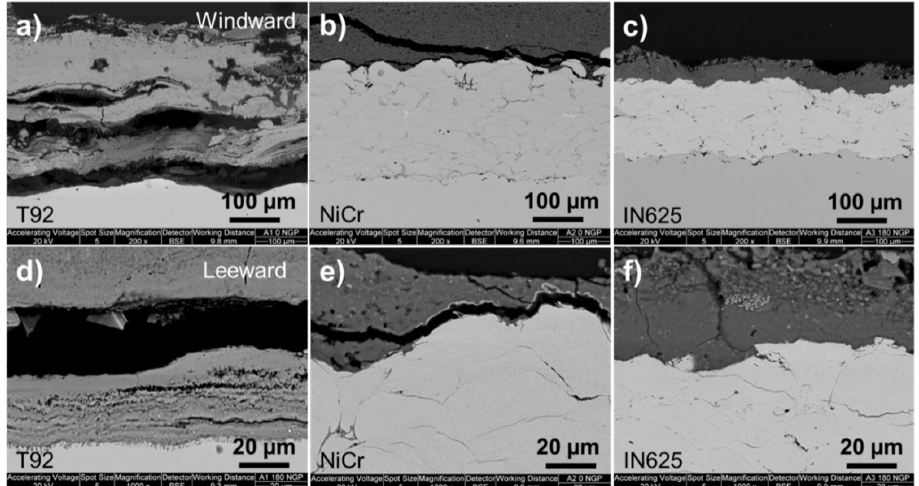
Figure 5. SEM (BSE–Back scattered electron) images of the cross-section of the specimens after the 1300 h exposure at 550 ◦ C: ( a – c ) Windward side of T92, NiCr and IN625 coatings; ( d – f ) Same materials at the leeward side.